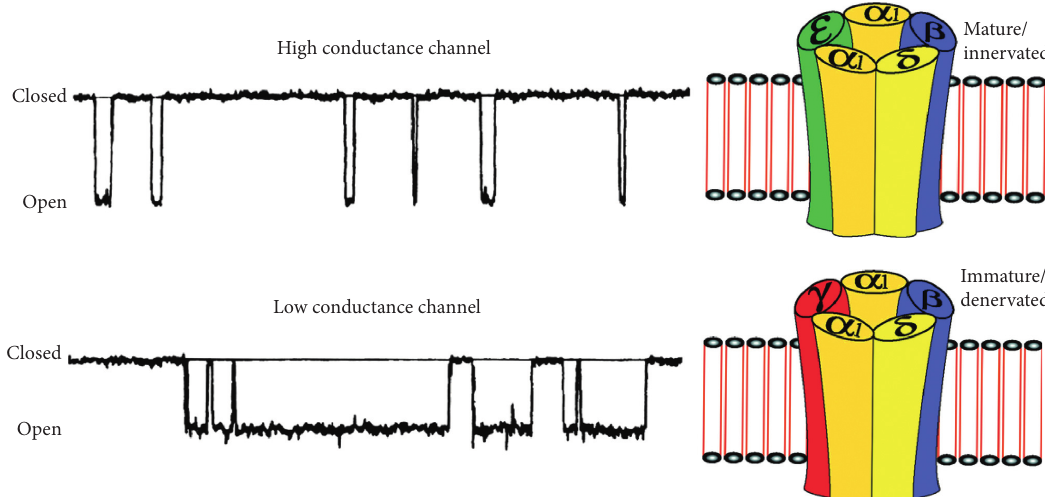
Figure 1: Outline of muscle acetylcholine receptor channels (right) and tracings of cell patch records of receptor channel openings (left). The acetylcholine receptor consists of five subunits. The mature receptor consists of two α 1 subunits, and one each of β 1, δ , and ε subunits. The immature isoform consists of two α 1 subunits and one β 1, δ , and c subunit. The five subunits form a transmembrane cation channel. The immature receptor shows long opening times and low-amplitude currents and is therefore considered a low conductance channel. It may be depolarized with lower concentrations of agonists. The fact that these immature channels remain open for longer and are upregulated in certain pathologic states increases the chance that intracellular potassium ions will leak to the extracellular space following activation of the acetylcholine receptor with suxamethonium, acetylcholine, or choline and illustrated with permission from Wolters Kluwer